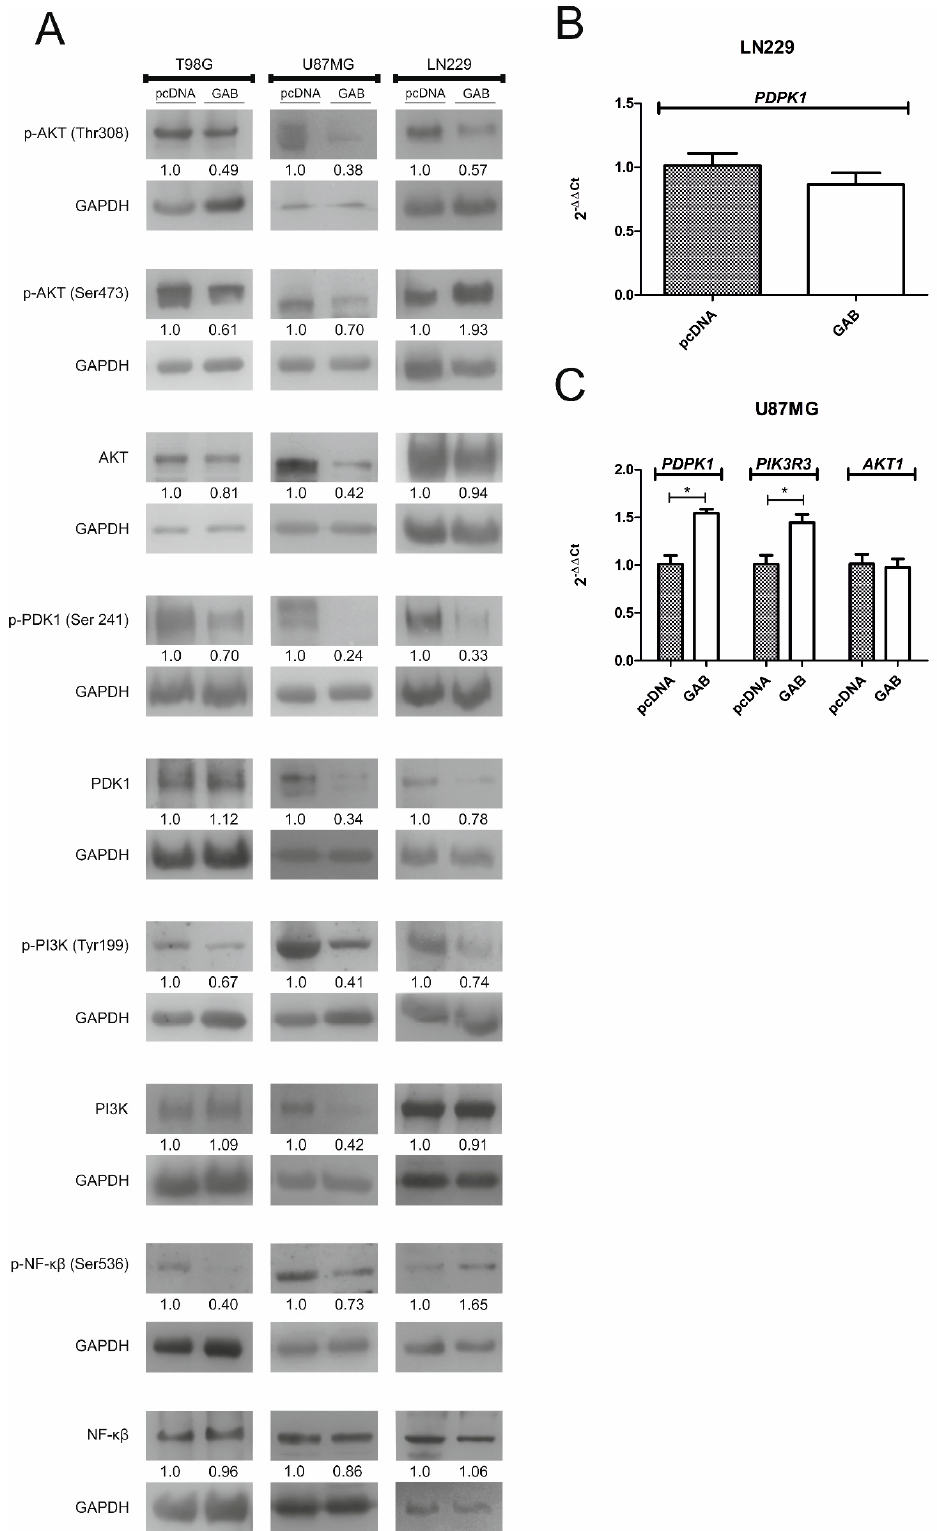
Figure 6. Transfection with the GAB sequence alters the level of proteins related to the PI3K/AKT signaling pathway upon H 2 O 2 treatment. ( A ) The level of proteins were analyzed by the Western blot analysis in (i) TpcDNA and TGAB cells after the treatment with 300 µ M H 2 O 2 for 1 h, (ii) UpcDNA and UGAB cells after the treatment with 5 µ M H 2 O 2 for 15 min, and (iii) LNpcDNA and LNGAB cells after the treatment with 5 µ M H 2 O 2 for 15 min. Results are mean ± SD ( n = 3–5) expressed as a